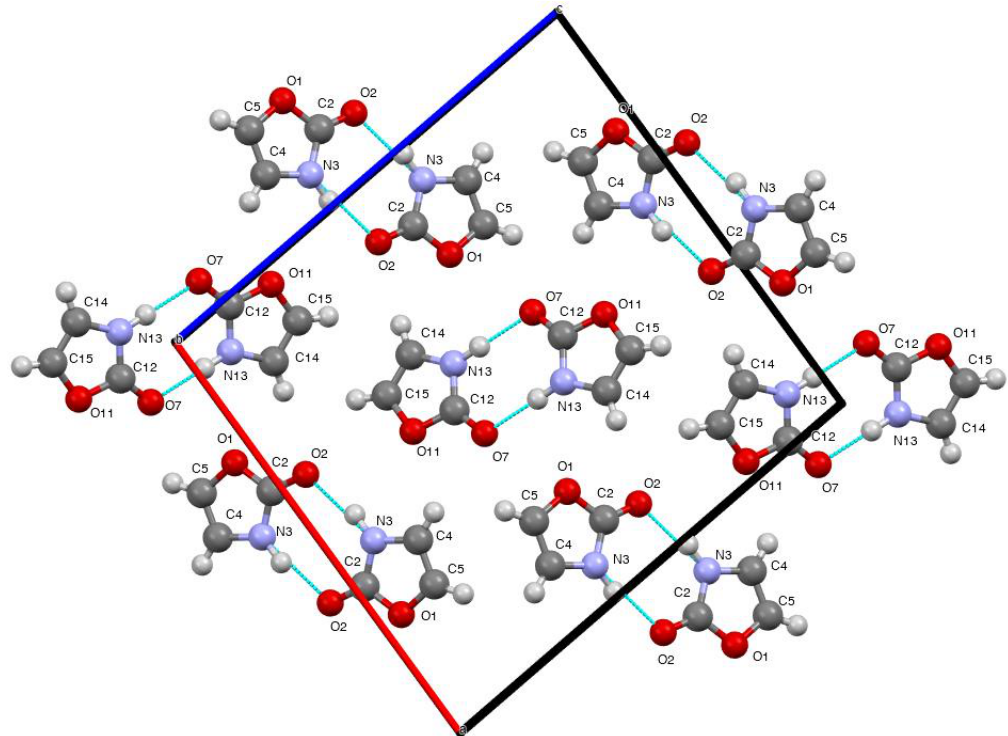
Figure 3. Structure and numbering of the two independent molecules of compound 4.